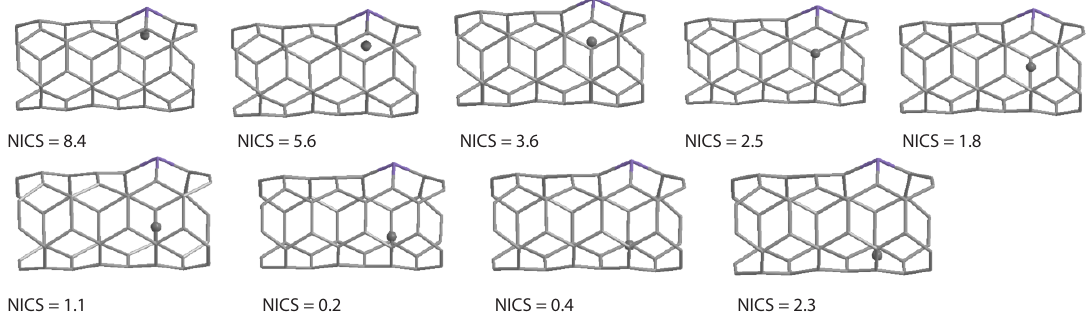
Figure 3. Radial NICS scanning of (3,3)-Si(L) (C